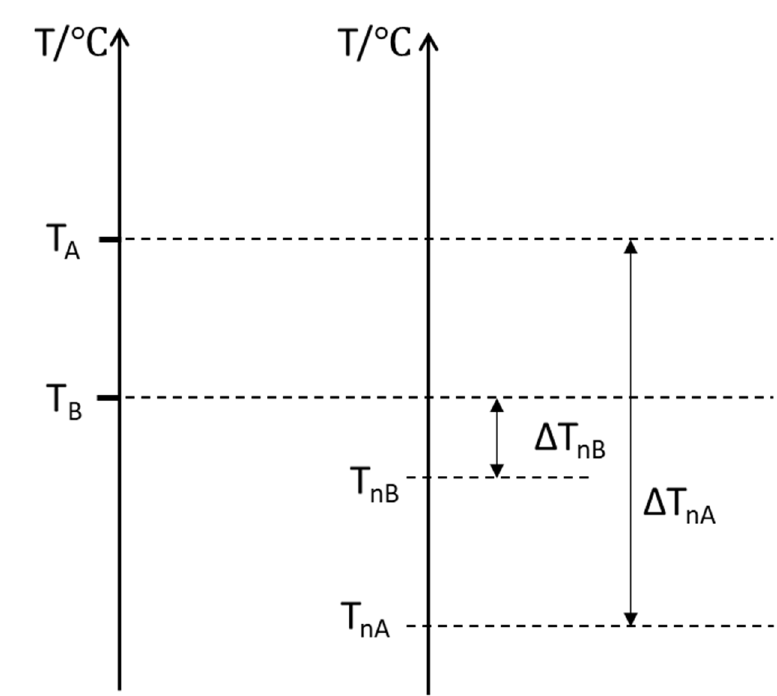
Figure 10. Schematic illustration of the competition for nucleation between two different types of FIMCs, A and B. T A and T B are the equilibrium formation temperatures of A and B, respectively. T nA and T nB are the actual nucleation temperatures of A and B, respectively. ∆ T nA and ∆ T nB are the actual nucleation undercoolings of A and B, respectively. Under such circumstances, B will nucleate first, although A has a higher formation temperature than B.